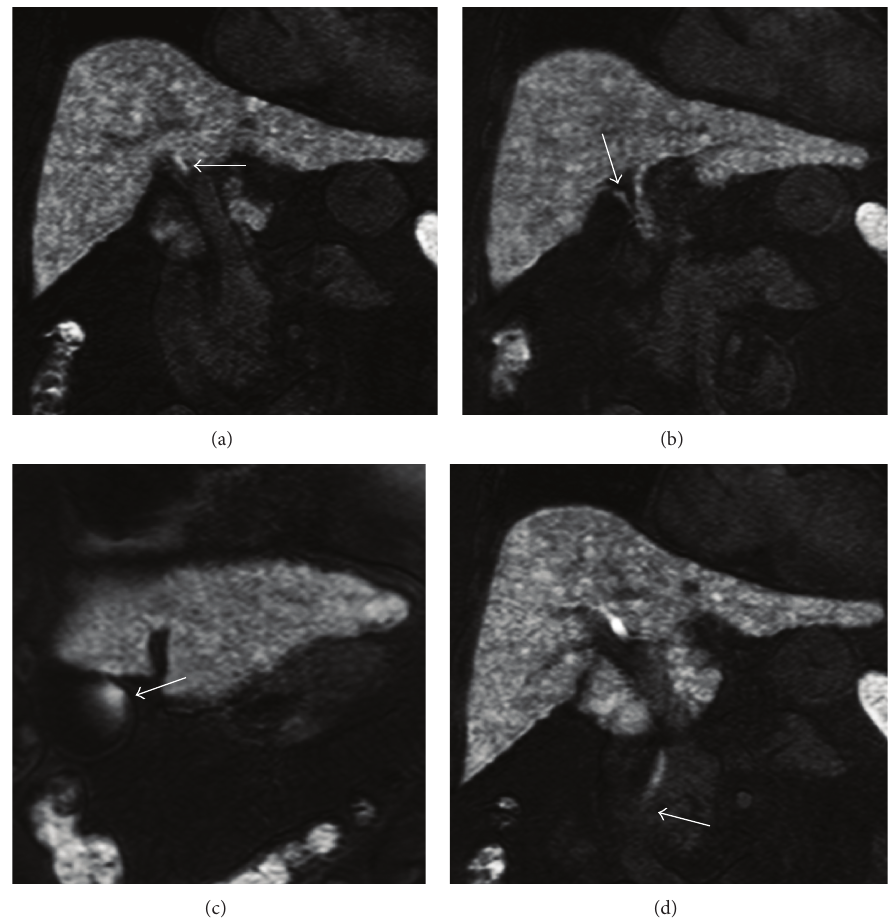
Figure 1: Orthodromic type of bile accumulation in gallbladder in a 72-year-old female with cryptogenic liver cirrhosis (Child-Pugh class-Pugh class A). MR cholangiography on coronal hepatobiliary phase (HP) imaging obtained after administration of Gd-EOB-DTPA demonstrates excretion of contrast media in common hepatic duct on 8 min (a) (arrow), cystic duct on 10min HP image (b) (arrow), gallbladder on 12min HP image (c) (arrow), and end of CBD on 16 min HP image (d) (arrow). This patient did not have stone, wall thickening, and T1 hyperintense bile in gallbladder (not